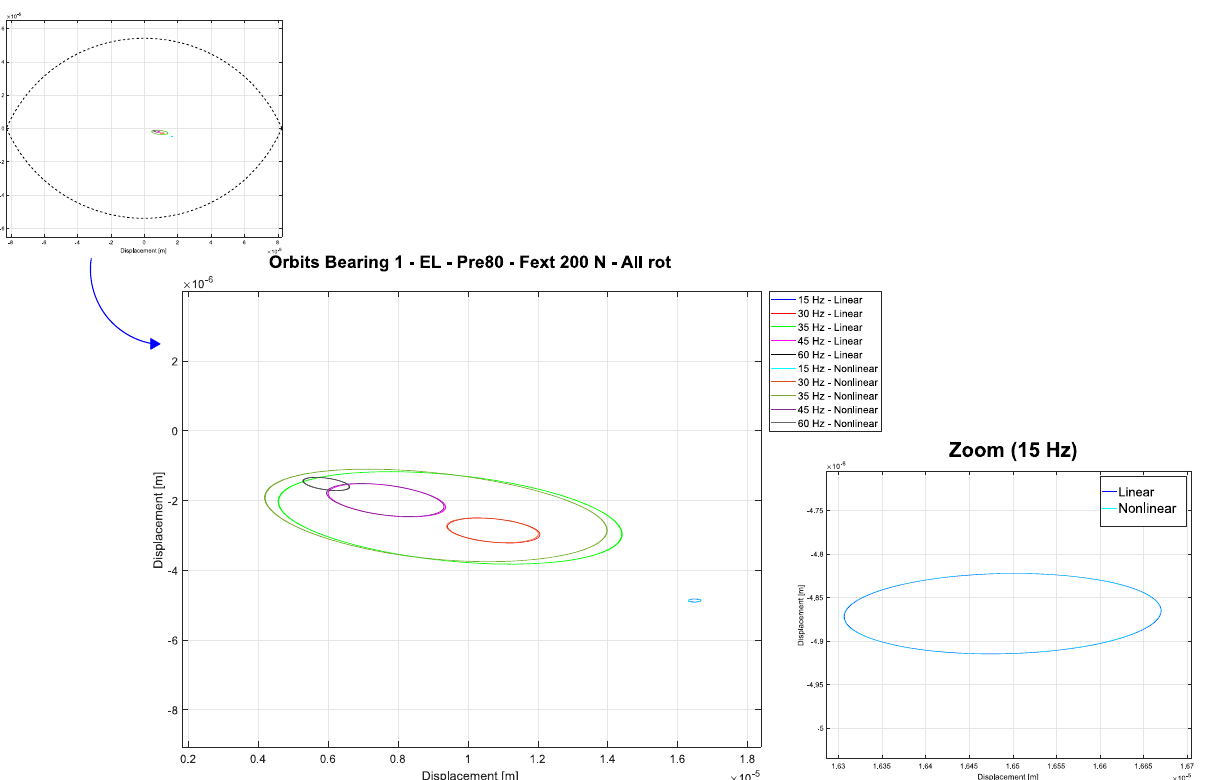
Figure 6. Orbits for all rotations simulated in elliptical bearing 1 (preload 0.8), with zoom in rotation 15 Hz.